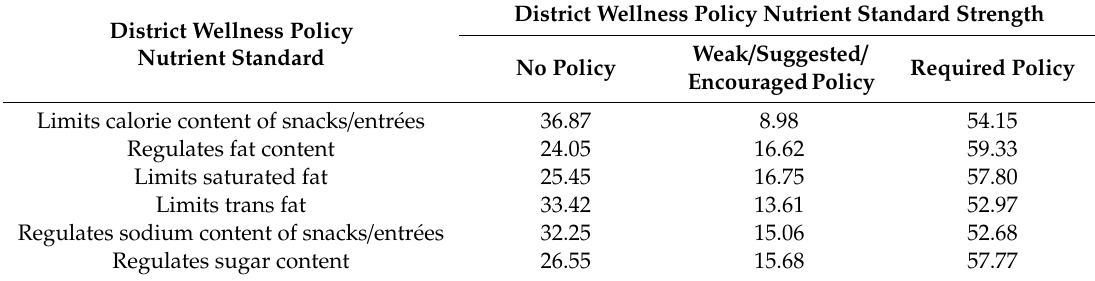
Table 2. District wellness policy nutrient standards